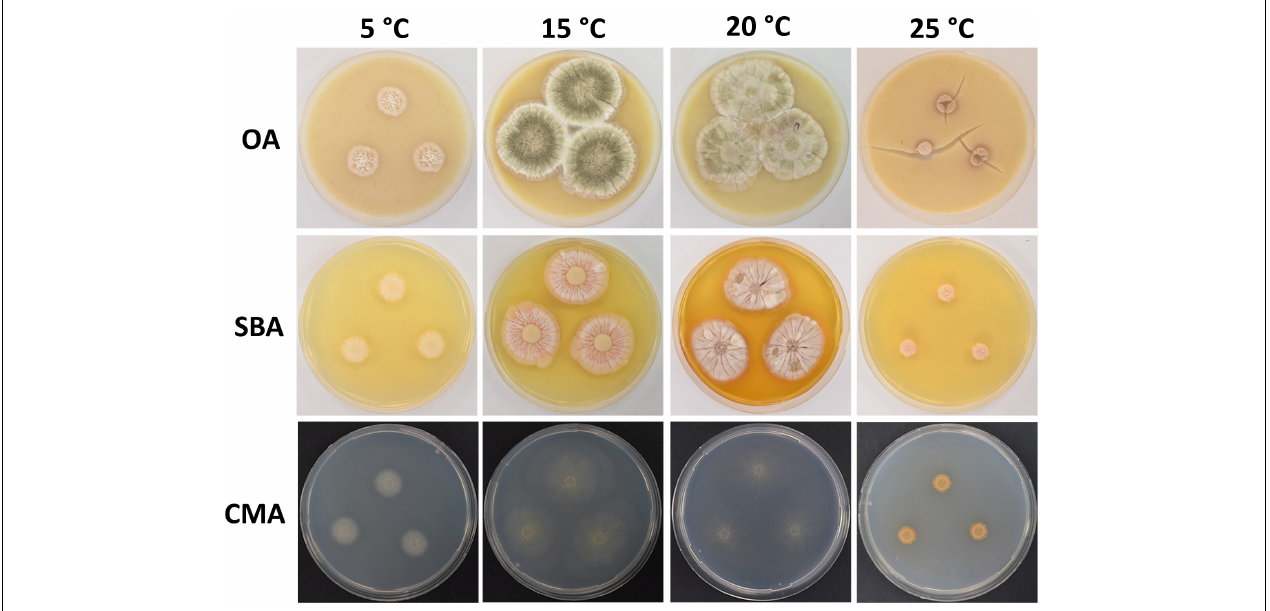
FIGURE 2 | Colony morphology of Pseudogymnoascus antarcticus sp. nov. grown on OA, SBA, and CMA media at 5, 15, 20, and 25 ◦ C after 28 days of incubation. The cracked agar observed in OA at 25 ◦ C was not produced by a technical pitfall, but was produced by the growth of the fungus. Apparently, under these conditions, the fungus extracts most moisture, contracts agar, and cracks it. This was always observed in this medium at this